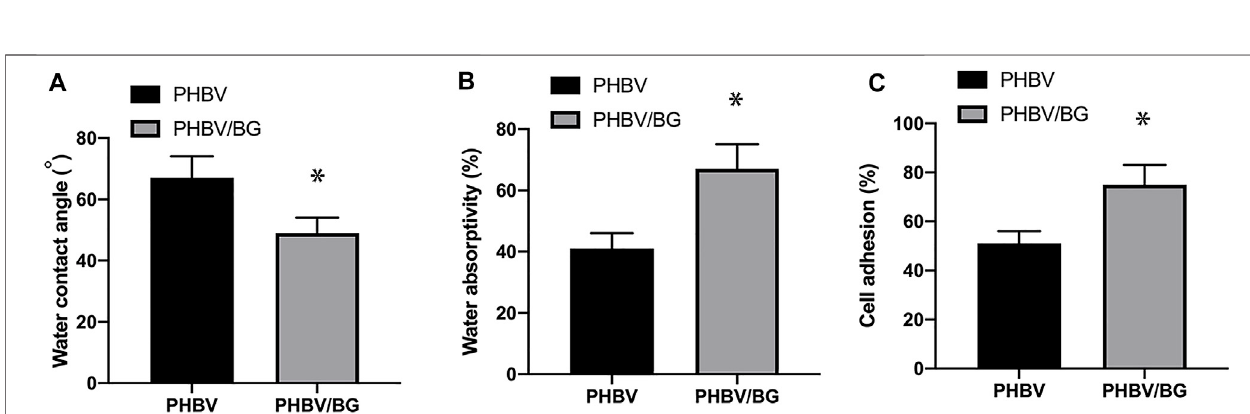
Frontiers in Bioengineering and Biotechnology |